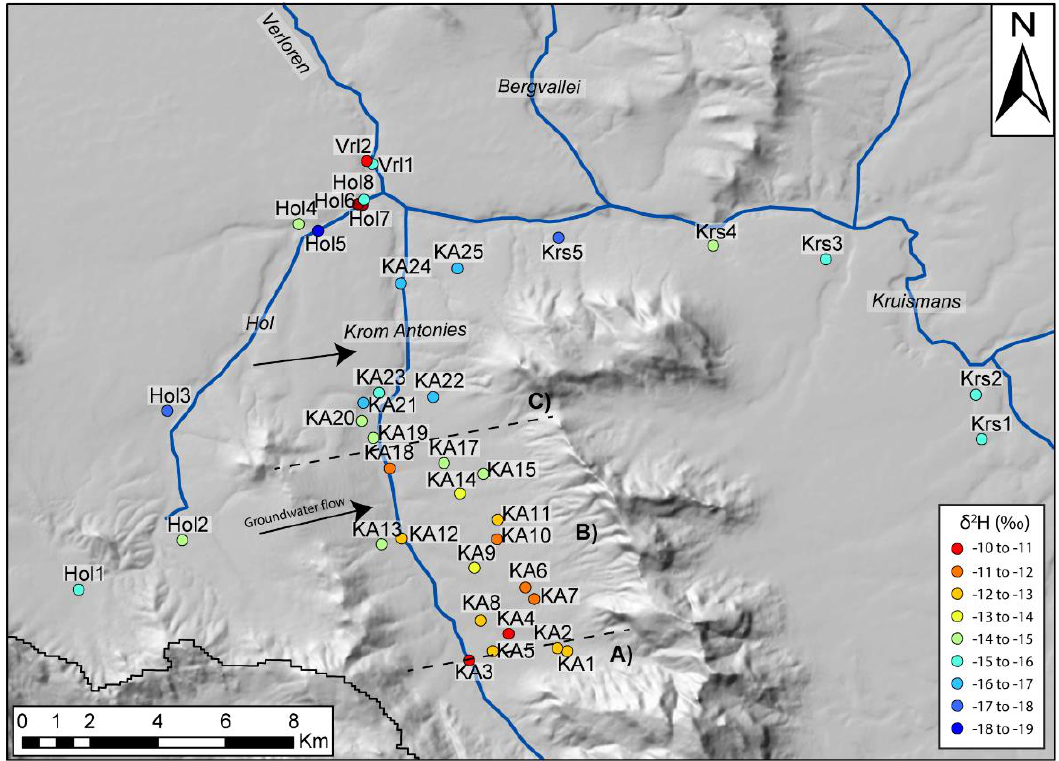
Figure 10. Delineation of groundwater zones along the Krom Antonies based on groundwater 2 H, where A is the upper Krom Antonies, B the middle Krom Antonies and C the lower Krom Antonies.